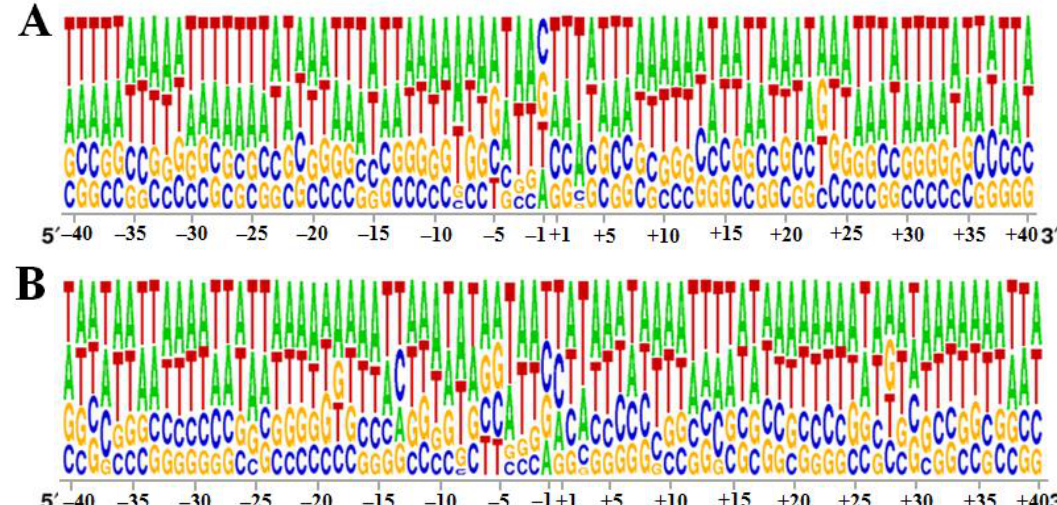
Figure 2. Base frequency within 40 bp around the integration site of EIAV FDDV13 in the horse genome. ( A ) Ssp I-digested horse genome; ( B ) Dra I-digested horse genome. The diagrams were generated using the WebLOGO program (Available online: http://weblogo.berkeley.edu/). The relative lengths of the nucleotides on the Y-axis represent the frequency of each base.